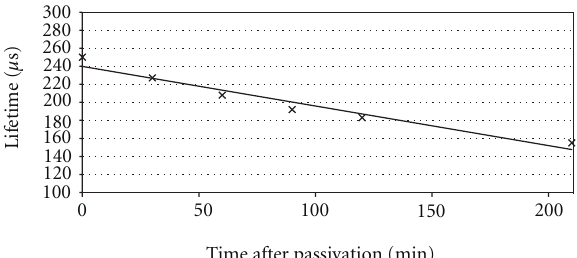
Figure 3: Comparison of the passivation startup between QM005, and